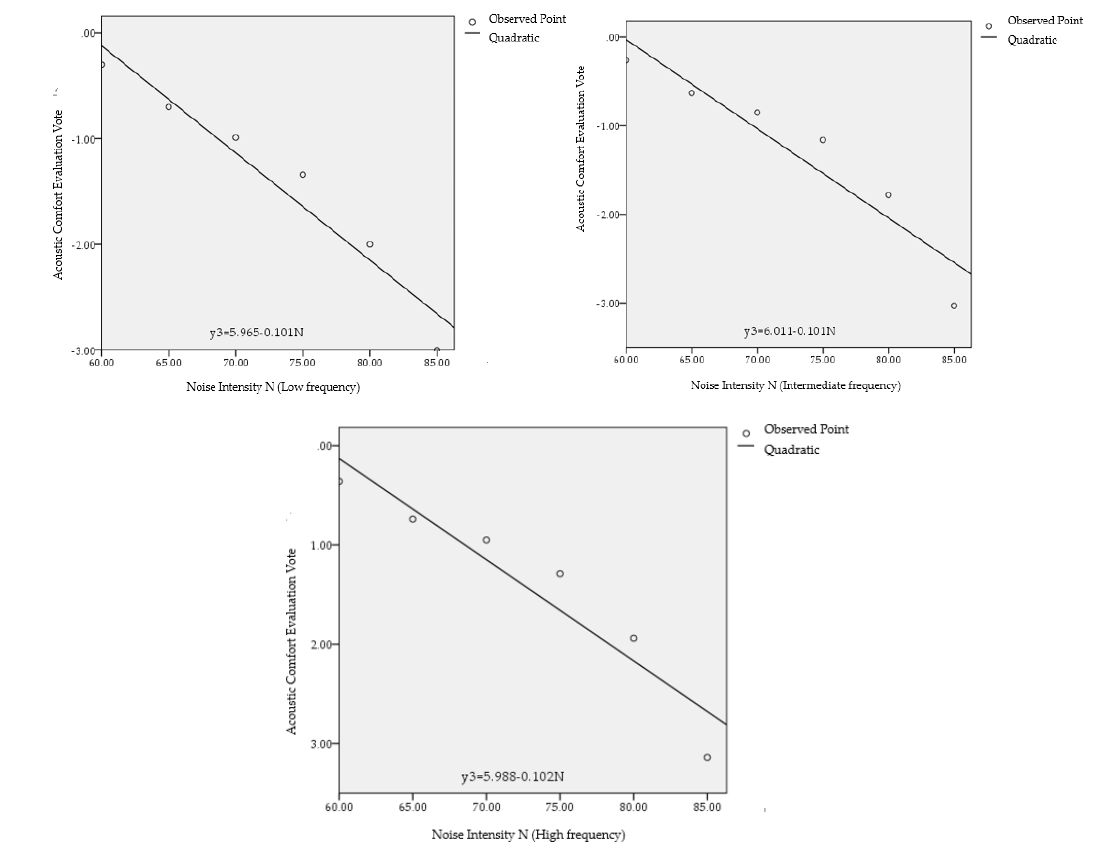
Figure 8. Acoustic comfort evaluation vote. Table 2. Piecewise function of non-dimensional acoustic environment.